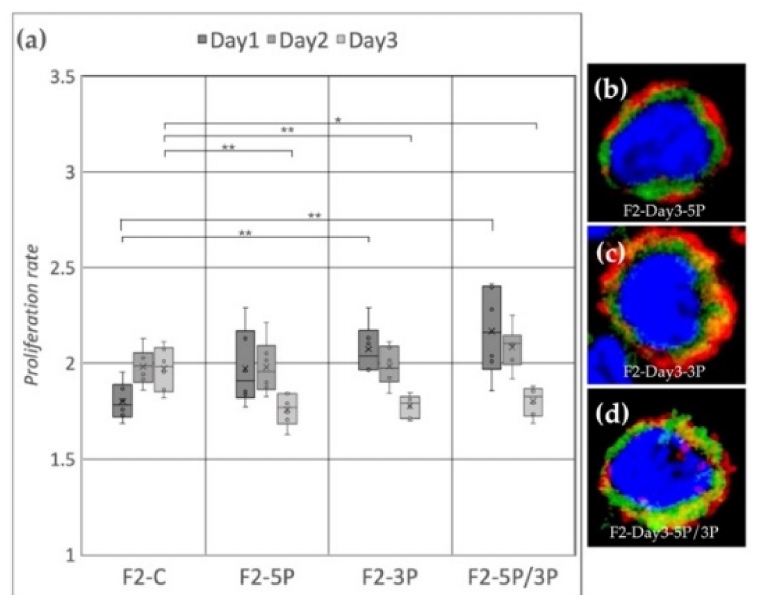
Figure 7. ( a ) Proliferation rate of F2 (ZW genotype) PGC line on Day 1, Day 2 and Day 3. F2-C: non-inhibited, F2-5P: gga-miR-302b-5P inhibition, F2-3P: gga-miR-302b-3P inhibition, F2-5P/3P: gga-miR-302b-5P and gga-miR-302b-3P inhibition. ( b – d ) Immunostaining of F2 PGCs after three days of cultivation with different culture conditions. The immunostaining was achieved with SSEA-1 (red), CVH (green) and TO-PRO™-3 for nuclear staining (blue) ( p < 0.05 *, p < 0.01 **).